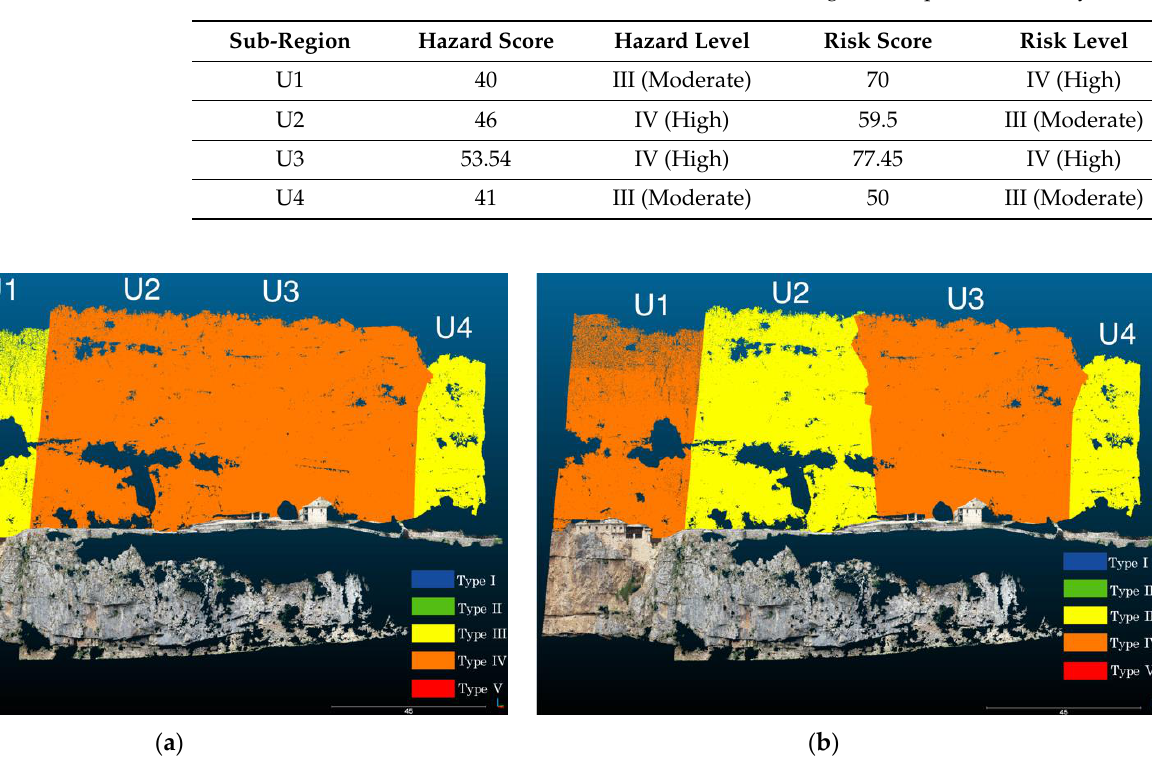
Table 10. The hazard and risk assessment results for each sub-region in Kipinas Monastery.